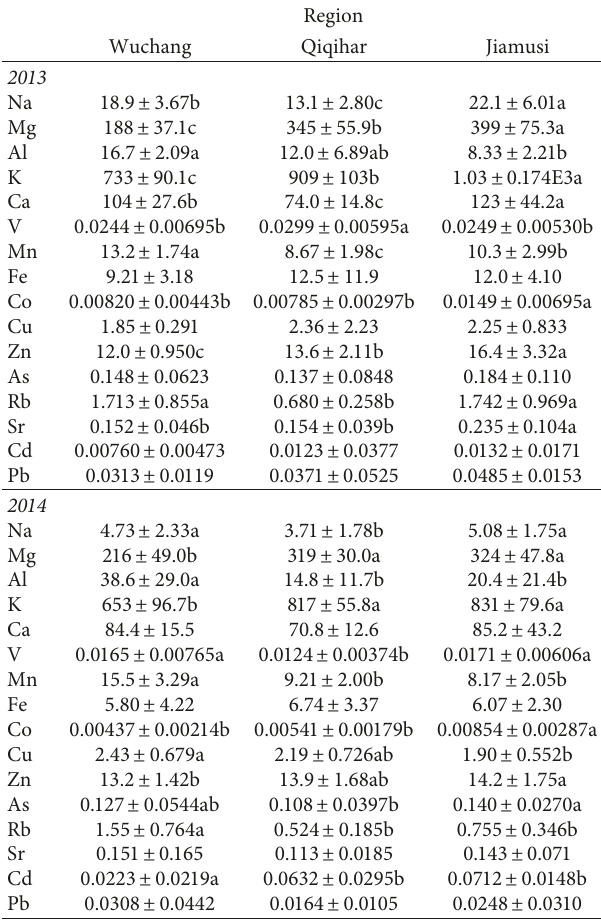
Table 2: Quality control for determining the elements of rice. Calibration range ( μ g/L)